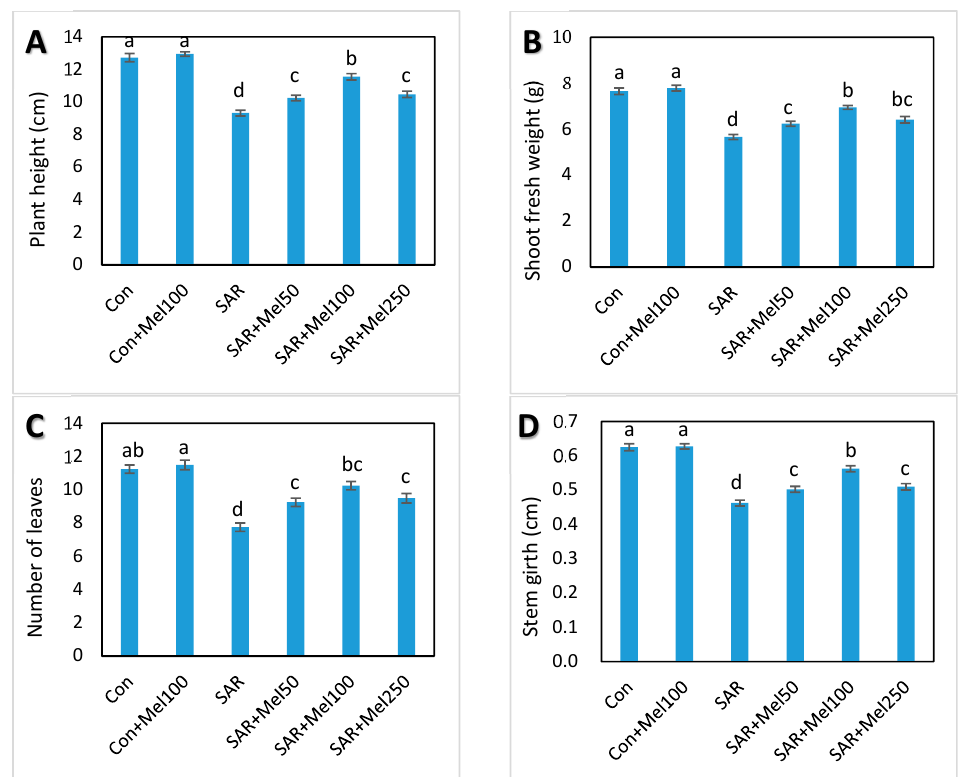
Figure 1. Changes of plant growth parameters in tomato plants by SAR and/or melatonin treatments. ( A ) plant height; ( B ) fresh weight of shoot; ( C ) number of leaves; ( D ) stem girth. Data indicates here the mean of four replications. Vertical bars indicate the standard error. Means not sharing a common letter within the graph are significantly different at p ≤ 0.05 according to Turey’s test.